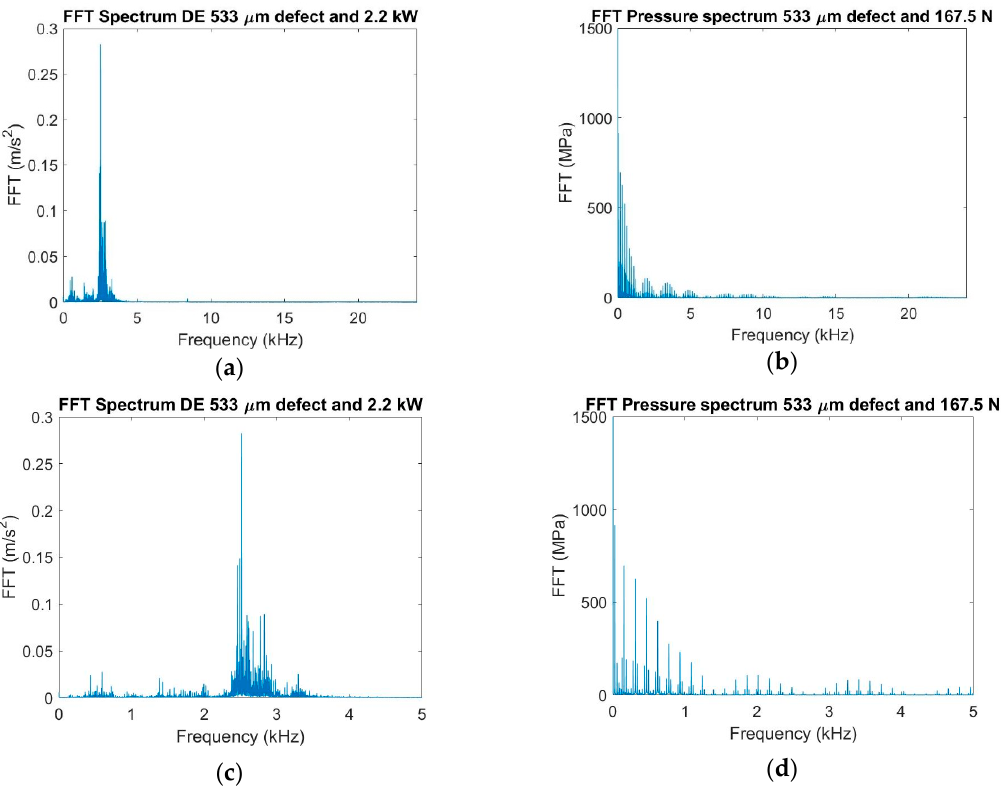
Figure 7. FFT raw spectra: ( a ) vibration signal, ( b ) pressure signal, ( c ) vibration signal up to 5 kHz and ( d ) pressure signal up to 5 kHz.